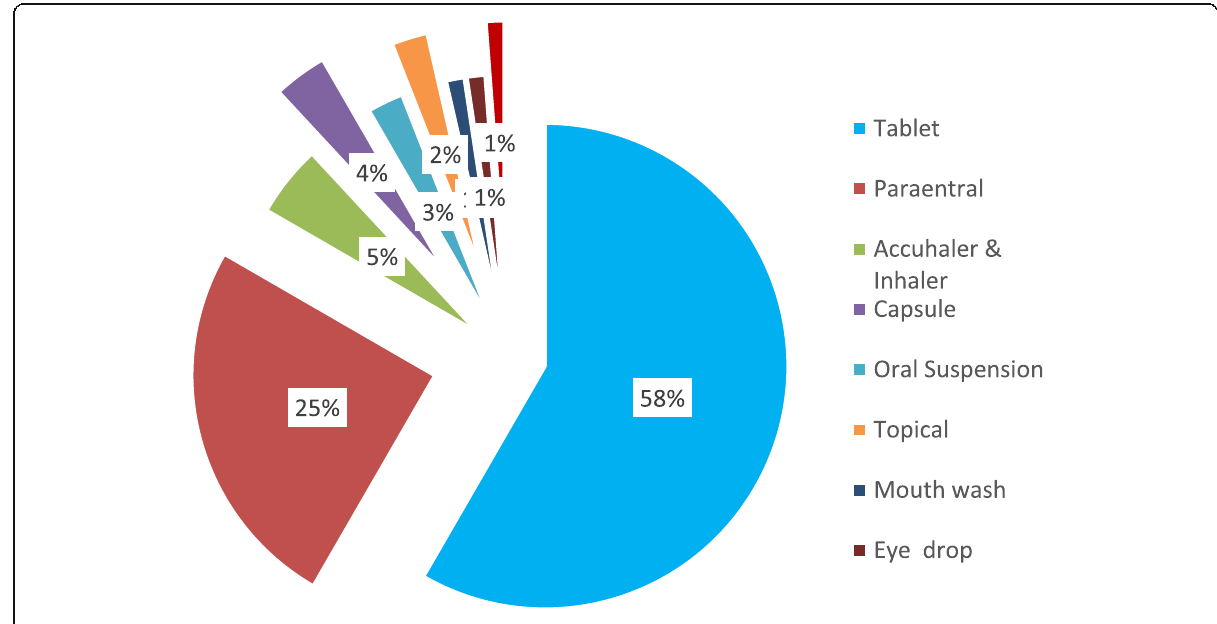
Fig. 2 Types of dosage forms of recalled medicines reported by Saudi